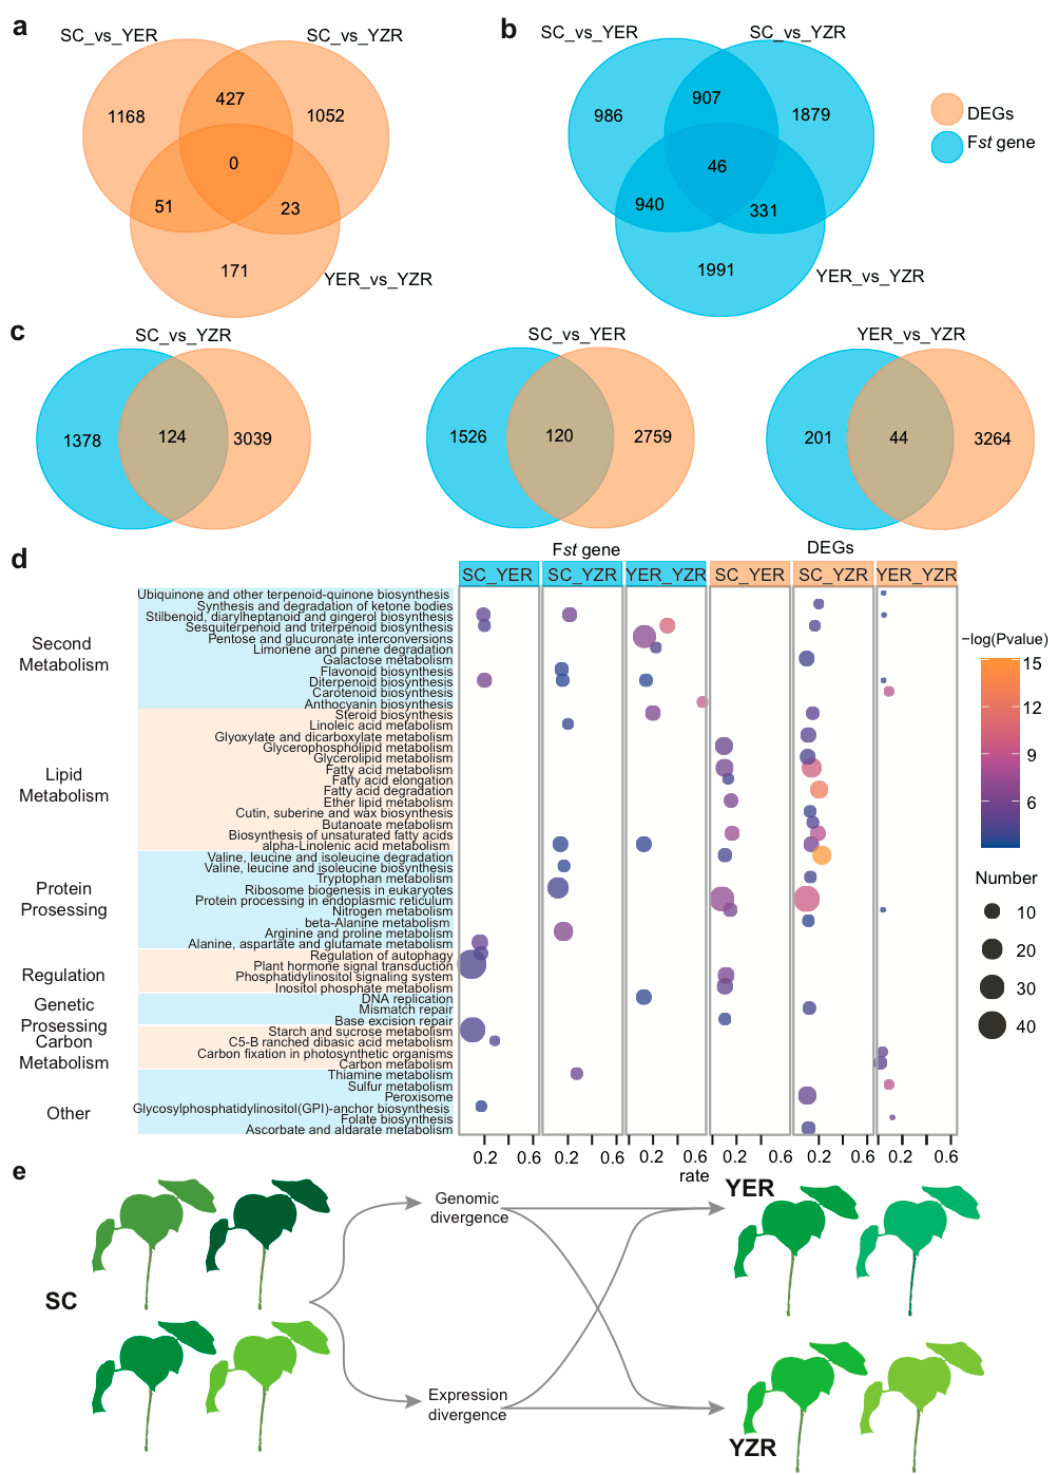
Figure 5. Analysis of different geographical distributions of G. arboreum. ( a ) Venn diagram showing the overlap of DEGs between South China (SC), Yellow River region (YER) and Yellow River region (YER). ( b ) Venn diagrams show the overlapping genes with a top 5% of pairwise fixation statistic (F st ) between SC, YER, and YZR. ( c ) Venn diagram shows the overlapping genes with different expression and top 5% pairwise fixation statistic (F st ) between SC, YER, and YZR. ( d ) KEGG enrichment of top 5% of F st genes and different expression genes between SC, YZR, YER. ( e ) Relationship of geographical distributions of G. arboretum